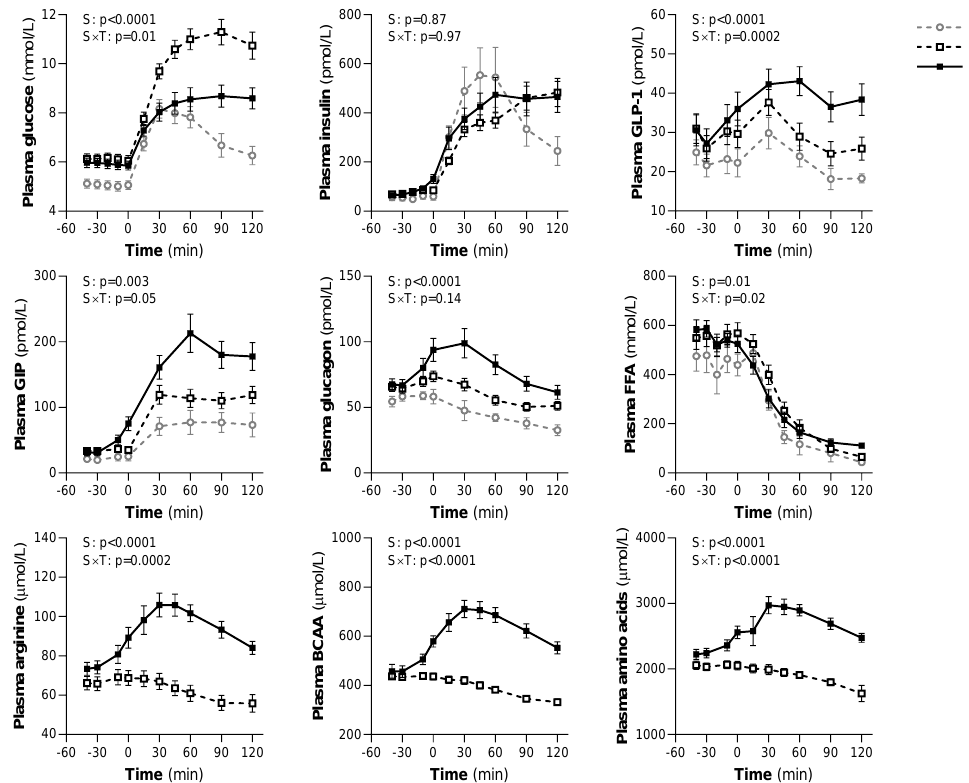
Figure 3. Plasma concentrations of glucose, insulin, glucagon-like peptide-1 (GLP-1), glucose-dependent insulinotropic polypeptide (GIP), glucagon, free fatty acids (FFA), arginine, branched-chain amino acids (BCAA), and total amino acids during two 75 g oral glucose tolerance tests preceded by water (CTRL) or a protein/lipid preload (PREL) in subjects with normal glucose tolerance (NGT) or abnormal glucose tolerance (AGT). Data are mean ± SEM. In AGT, repeated measures were analyzed by mixed models including study (S), time, and an interaction term (S × T) as fixed effects and subject as random effect. P values are not shown for time effects (<0.05 for all variables).